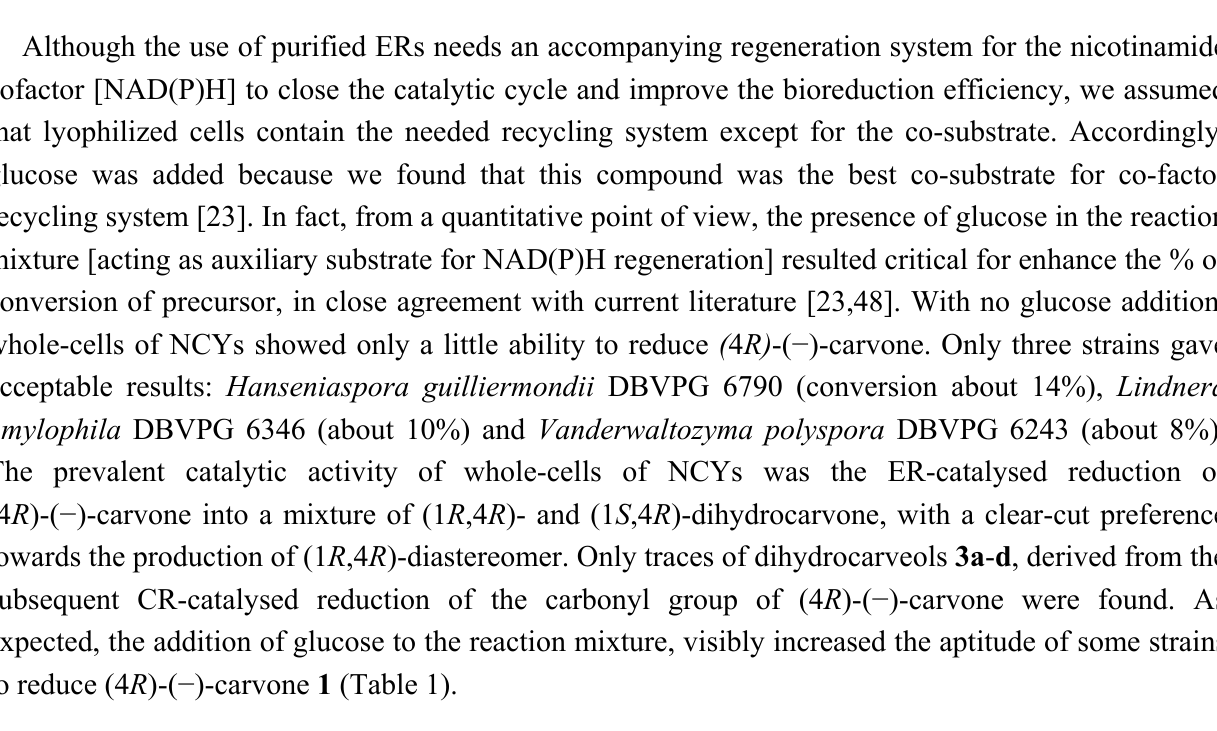
Table 1. Bioconversion of (4 R )-( − )-carvone 1 into derivative products after 120 h by whole-cells of NCYs in the presence of